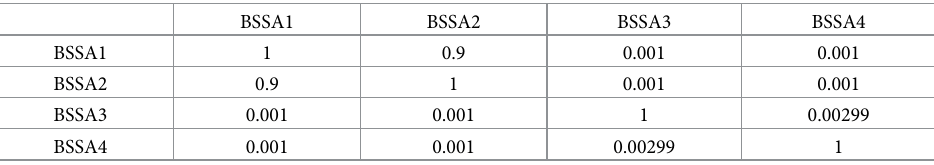
Table 4. p -values from Nemenyi post-hoc